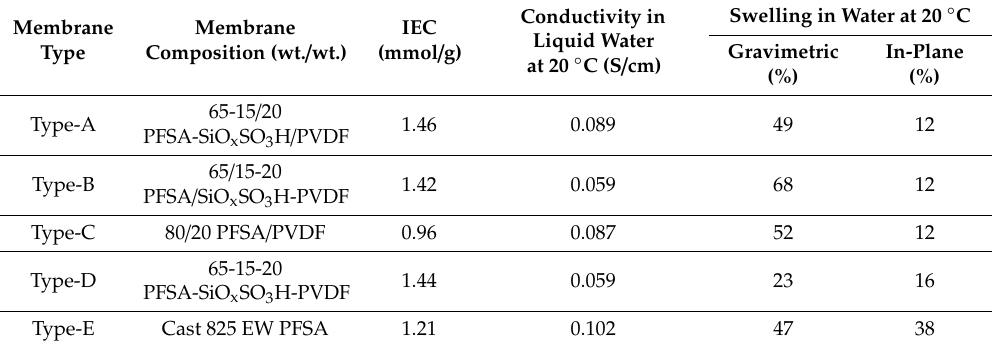
Table 4. Ionic exchange capacity (IEC), proton conductivity in water at 20 °C, in-plane and gravimetric